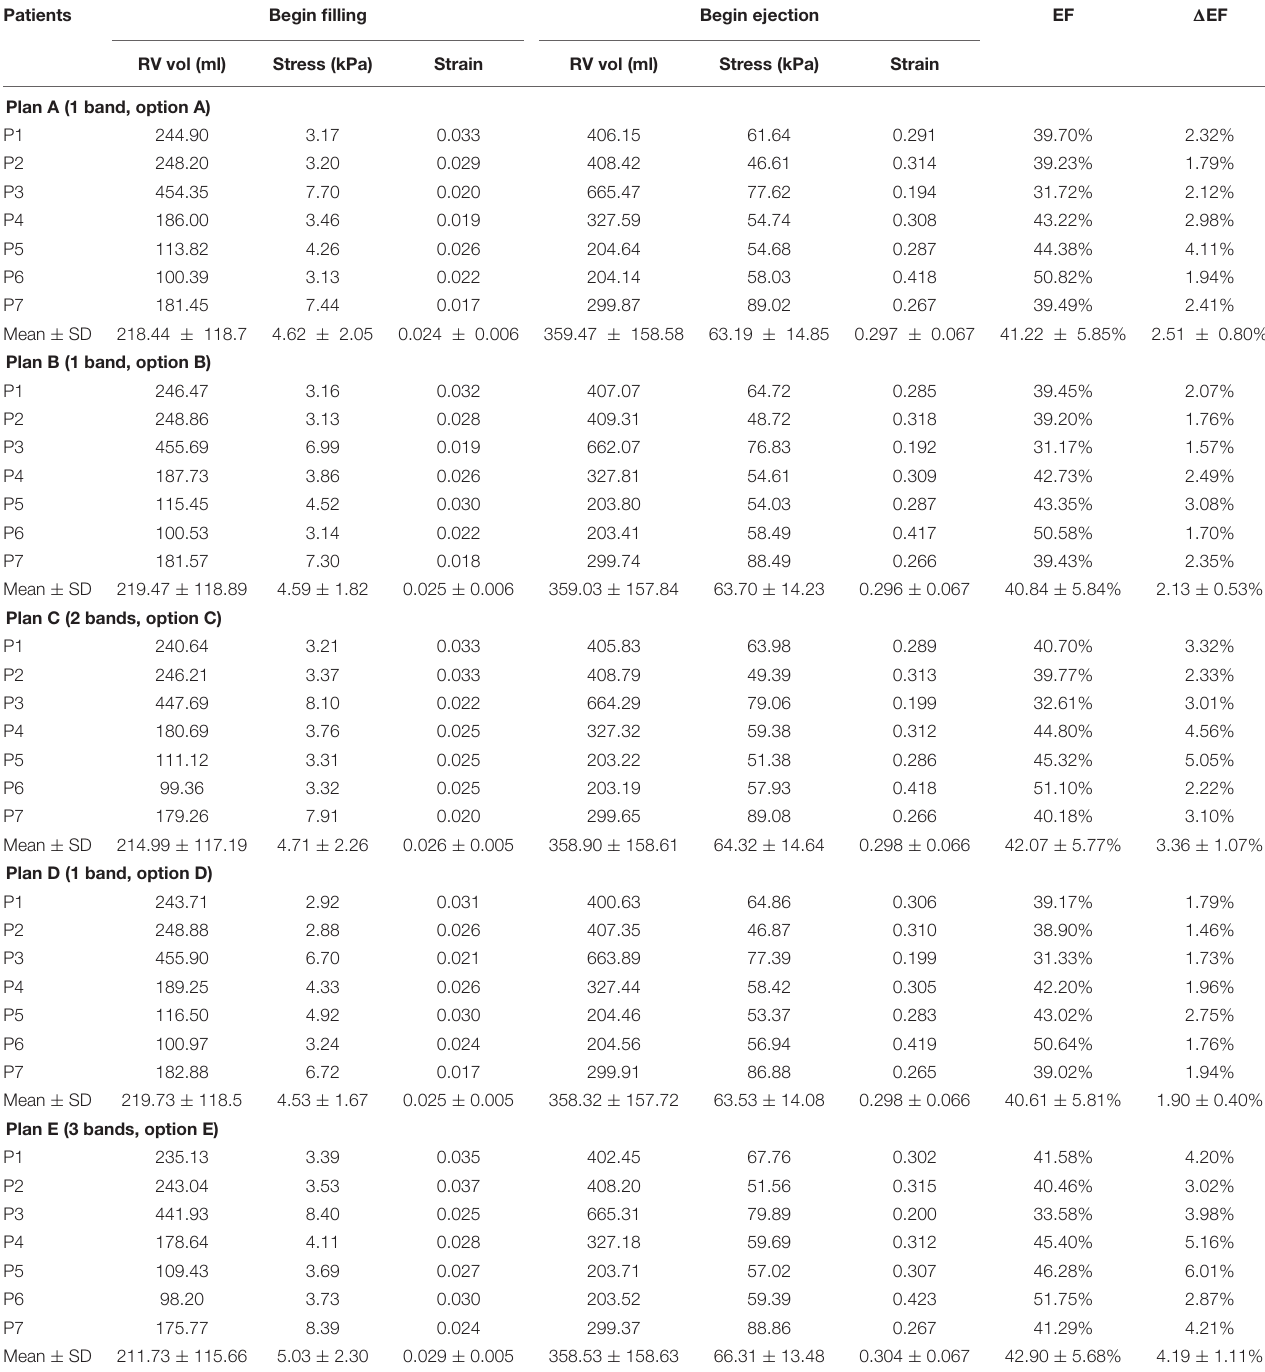
TABLE 4 | RV ejection fraction (EF) and wall stress/strain data from models with band active contraction ratio of 20%.